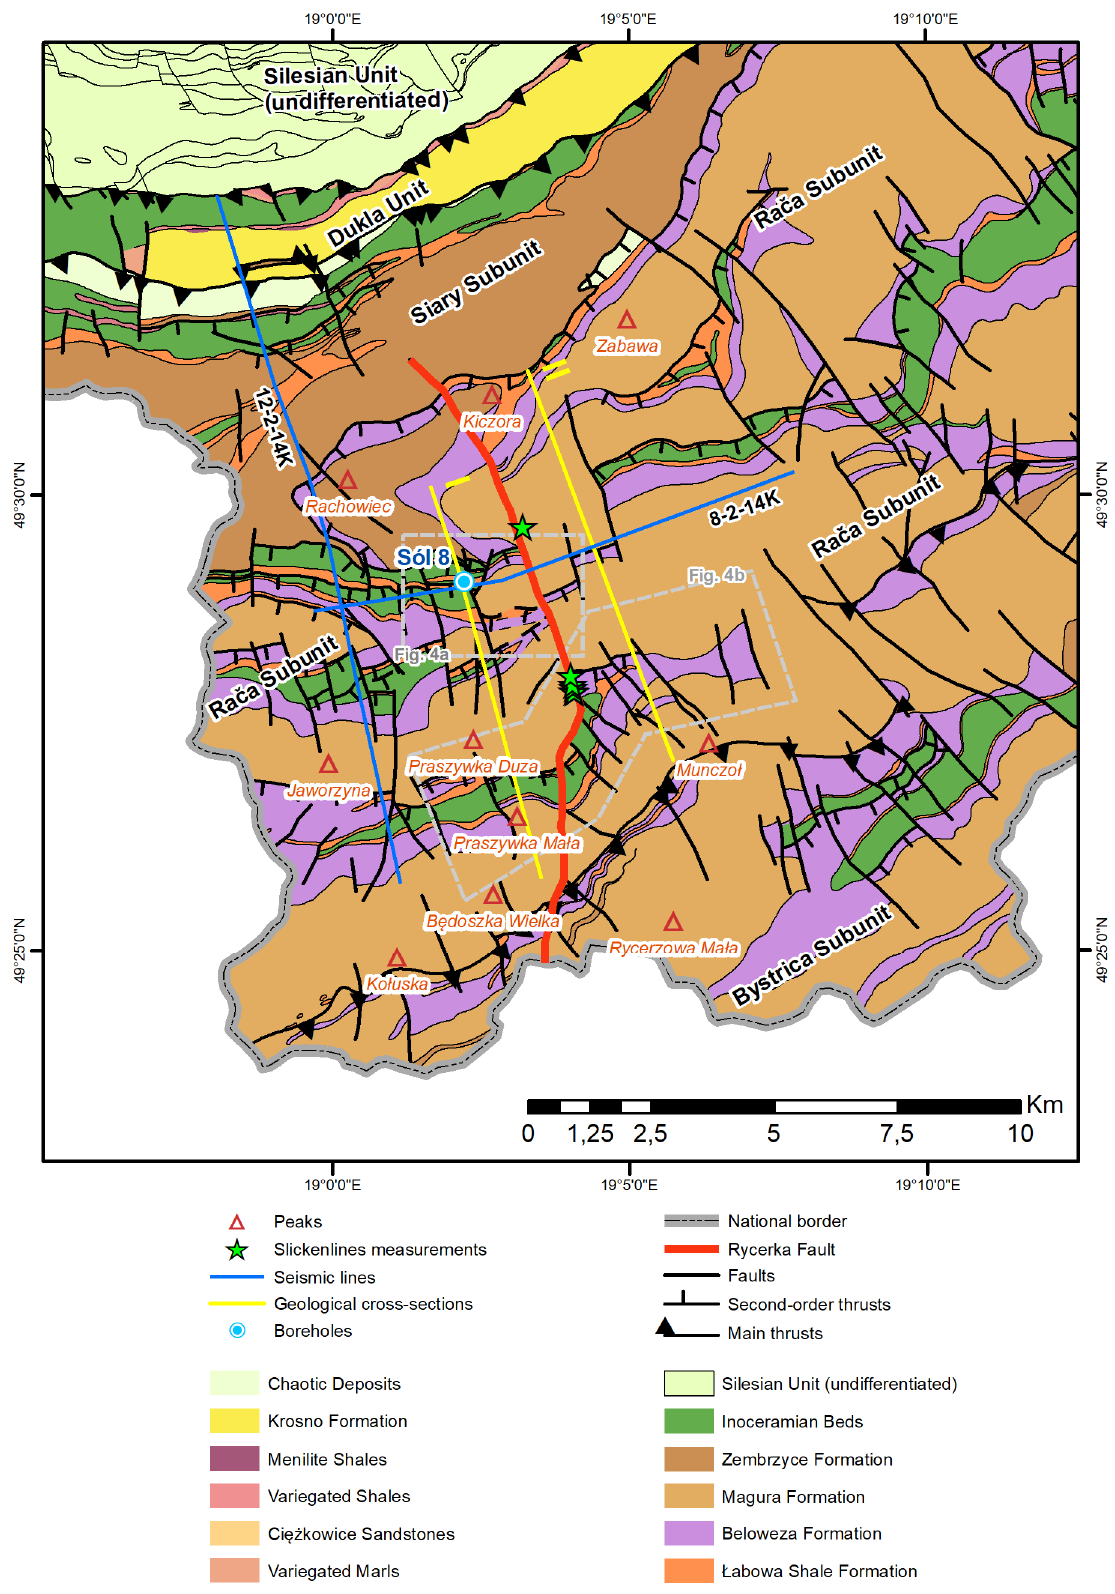
Figure 3. Detailed geological map of the research area (after [71], modified). 12-2-14K and 8-2-14K—seismic profiles presented in Figures 13 and 14. Zones marked with gray-dasked polygons are shown in subsequent figure. Green stars—outcrops with measurements used for stress inversion.